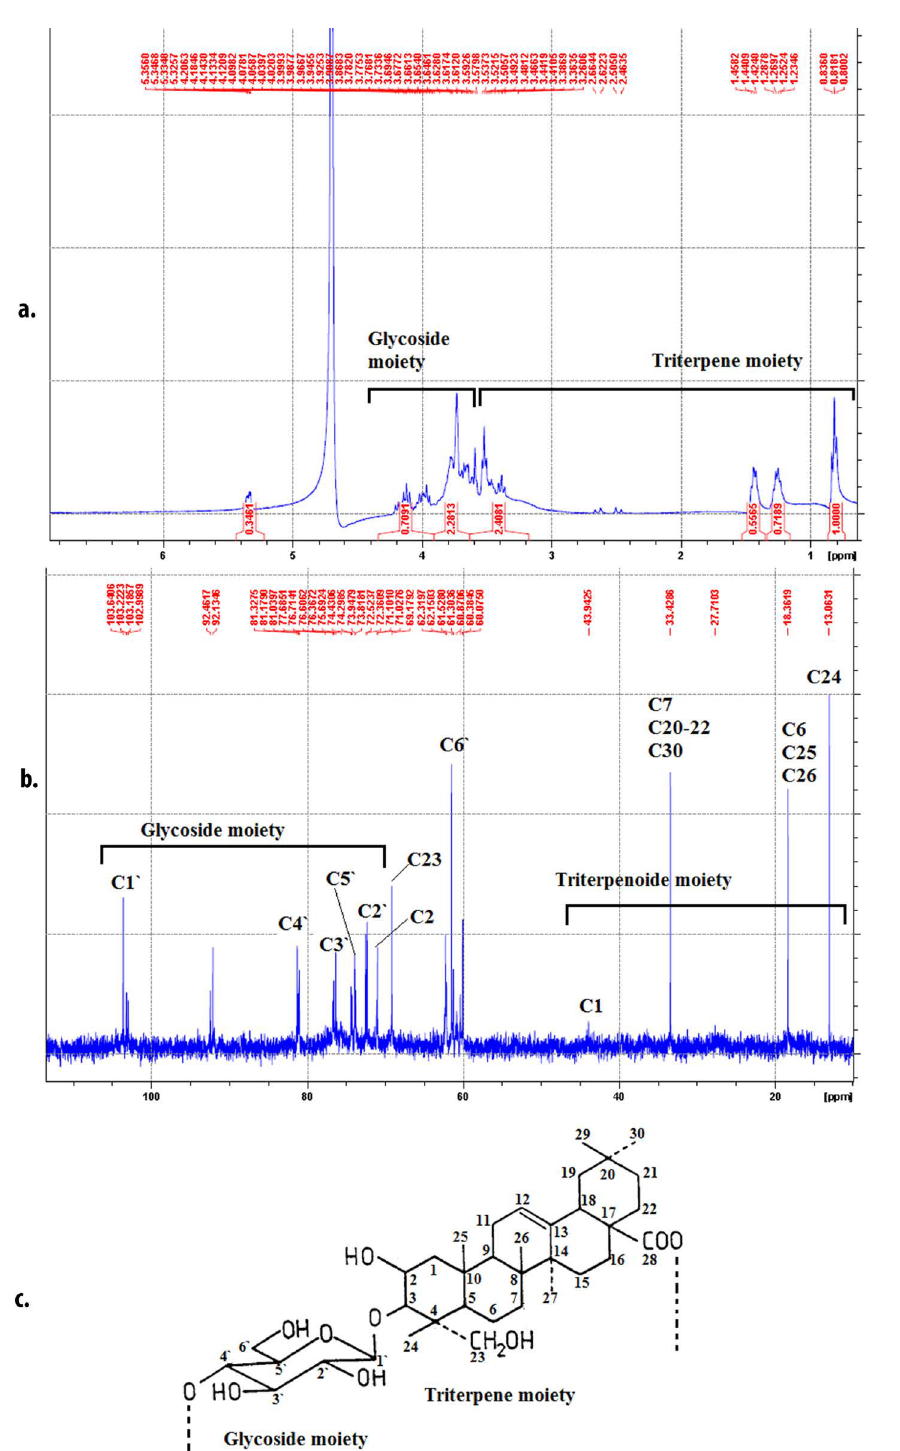
Fig. 1. 1 H-NMR (a) and 13 C-NMR (b) of methanol extract, and general structure of saponins with carbon numbers